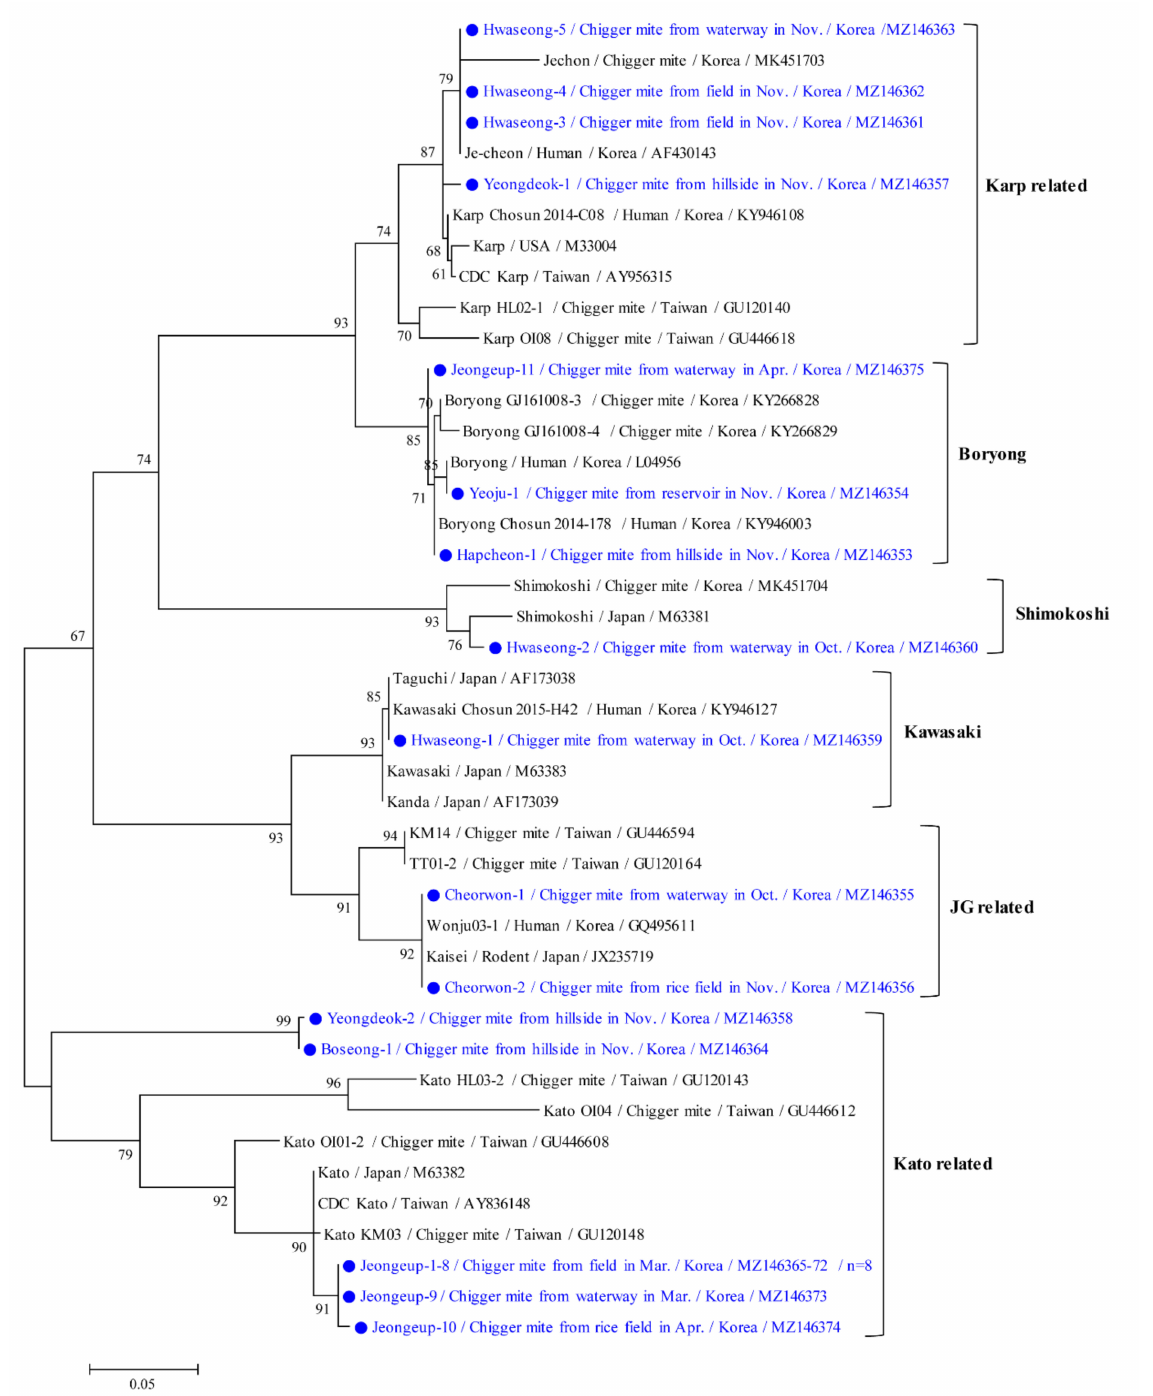
Figure 4. Phylogenetic tree of Orientia tsutsugamushi based on 56 kDa gene sequences. The maximum likelihood method was used to create the tree, and closed circles and blue letters indicate the sequences detected in this study. The GenBank accession numbers are shown, and the O. tsutsugamushi genotypic groups are indicated. Branch numbers indicate bootstrap support levels (1000 replicates), and the scale bar displays the substitution numbers for each